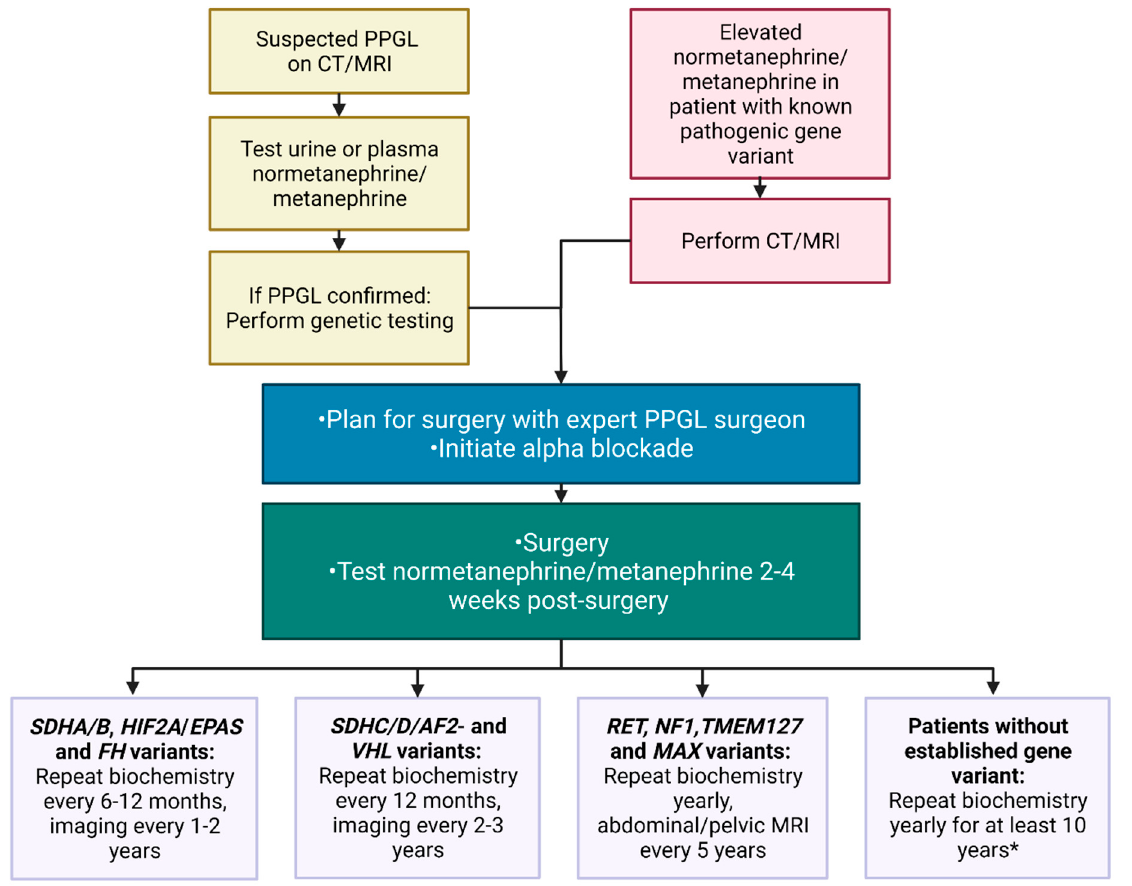
Figure 6. Proposed clinical flowchart for clinical management of PPGL patients. It is recommended to individualize man- agement due to factors such as age and aggressiveness of disease, which are factors not accounted for in this scheme. When interpreting normetanephrine/metanephrine levels, any drug effect must be excluded. *Recurrences may be de- tected after more than 10 years, so some departments advise lifelong annual follow-up with biochemical tests. Created with